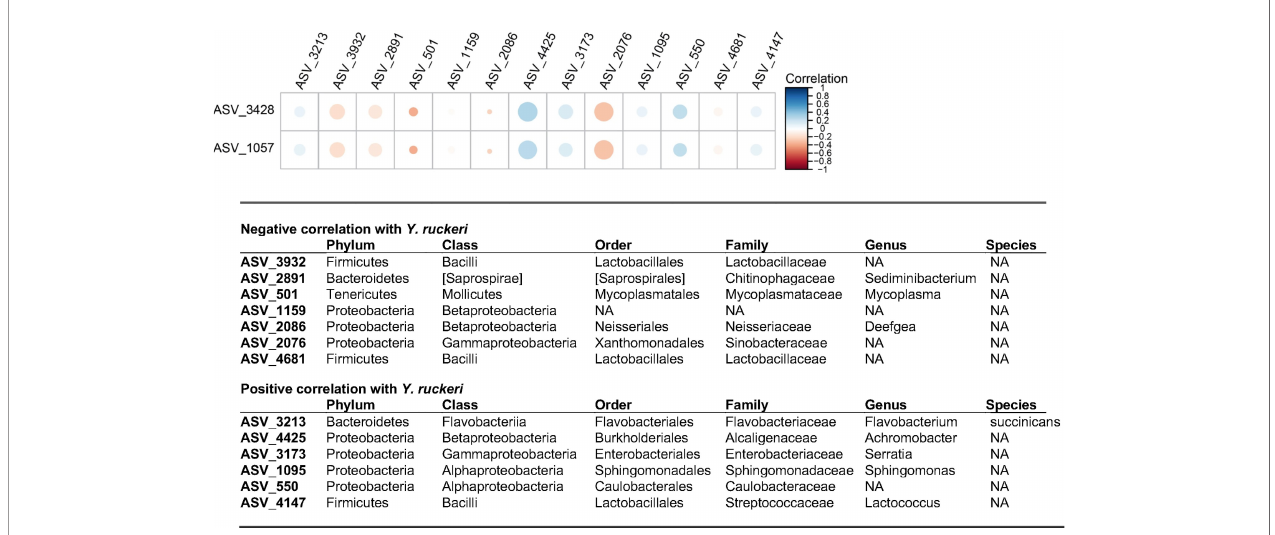
FIGURE 5 | Correlation analysis between ASV_3428 and ASV_1057 identi fi ed as Y. ruckeri and elements of the microbiome. All taxa shown have a statistically signi fi cant correlation (p < 0.05) to Y. ruckeri after correction. The size of the circles represents the signi fi cance of the correlation (larger circles have lower p-values) and the color denotes the direction and strength of the correlation. For example, ASV_4425 is strongly positively correlated to ASV_3428 and ASV_1057 with high statistical signi fi cance. Taxonomic assignments for each ASV were generated by comparison to the Greengenes database. NA, Not